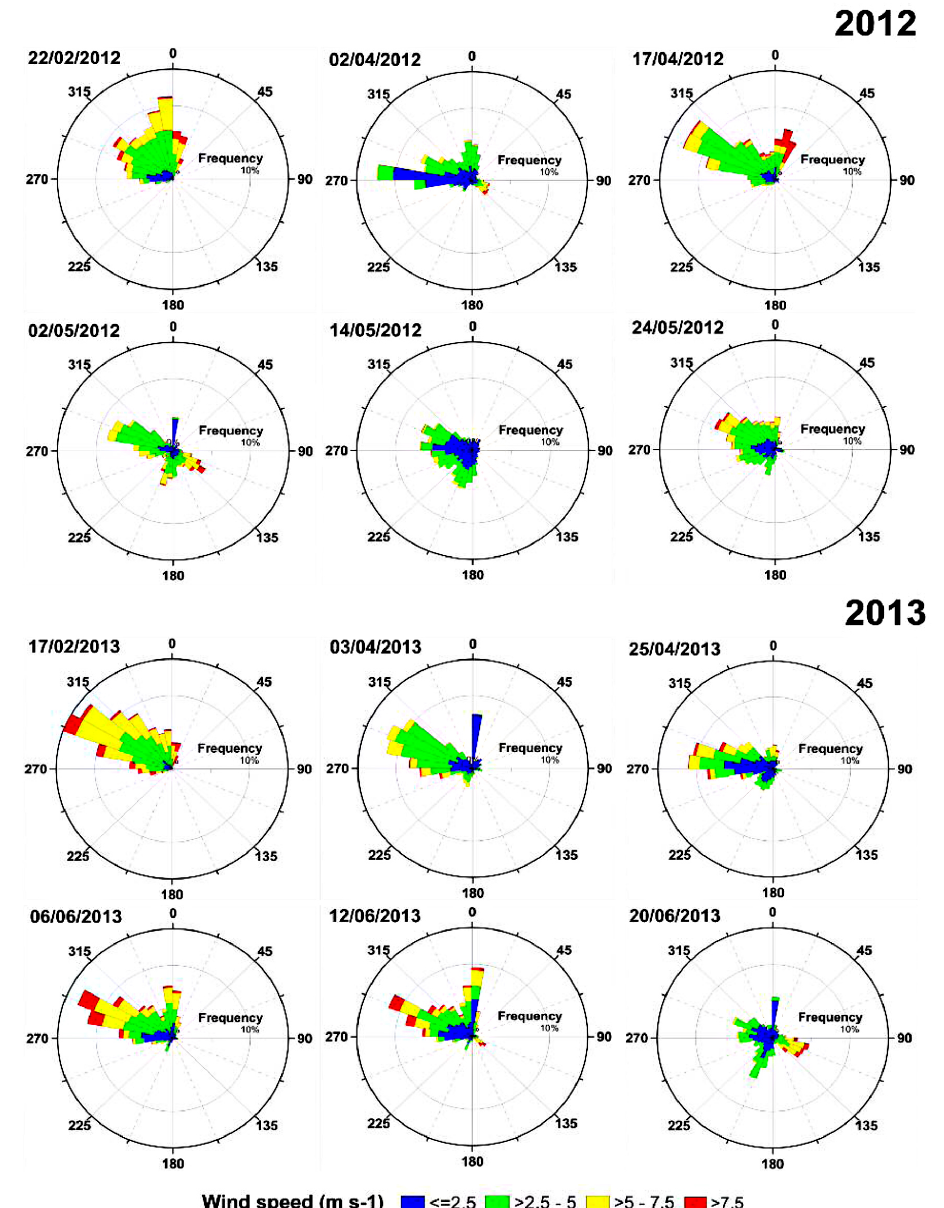
Figure 4. Wind roses from the automatic weather station placed at the catchment obtained for a 15-day